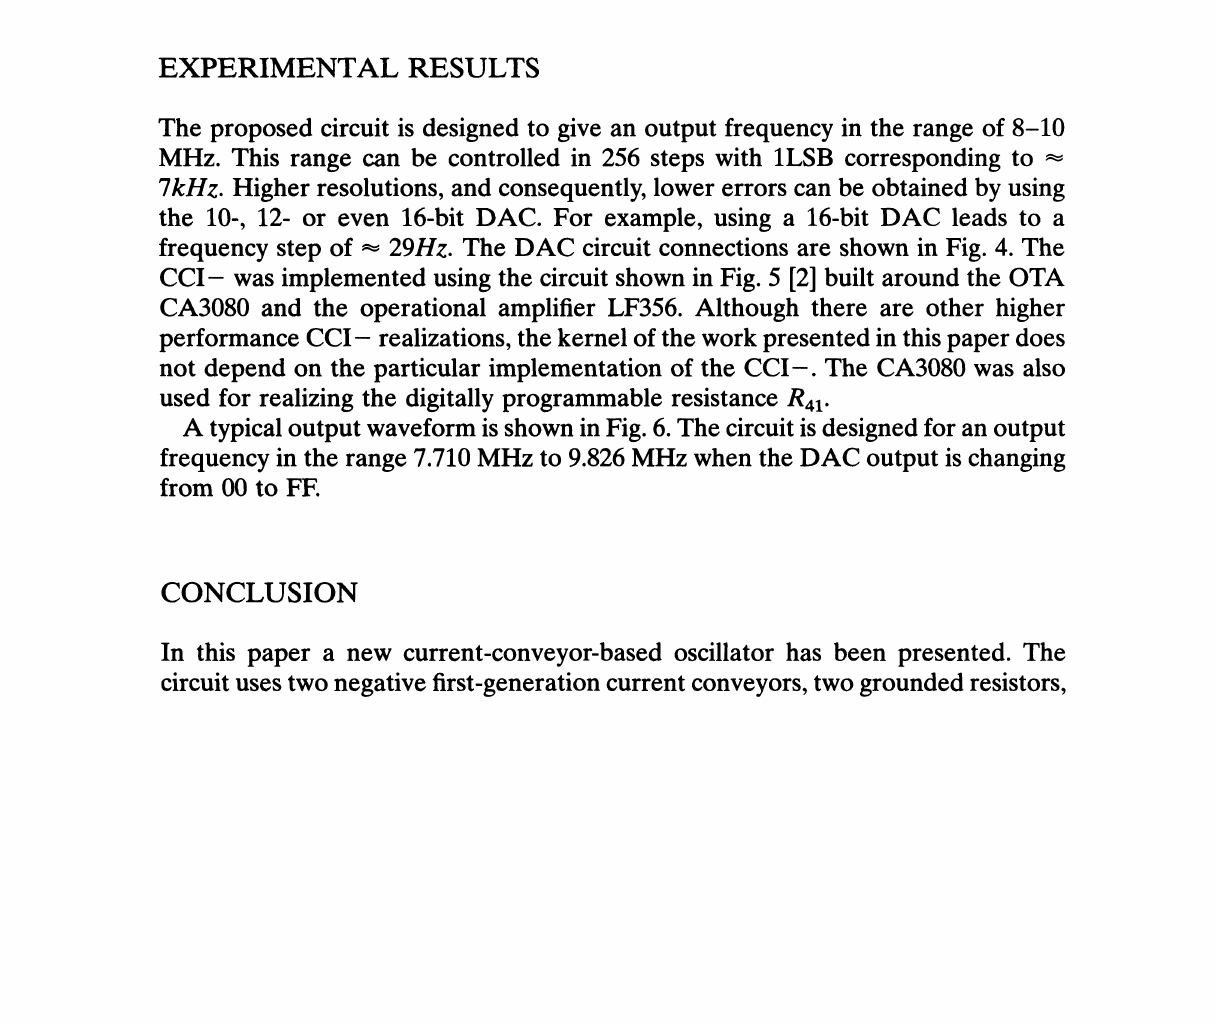
FIGURE 4 Digital-to-analog converter